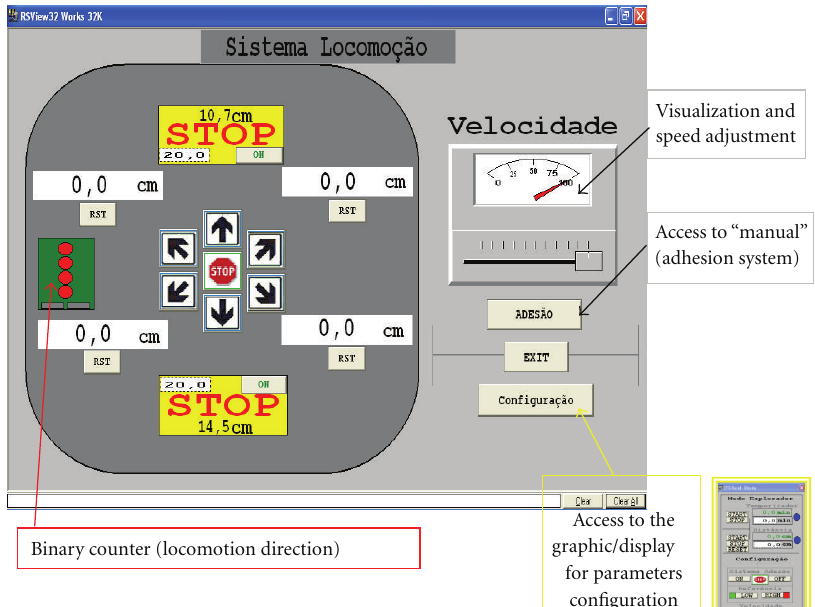
Figure 14: Picture of the graphic/display “Manual